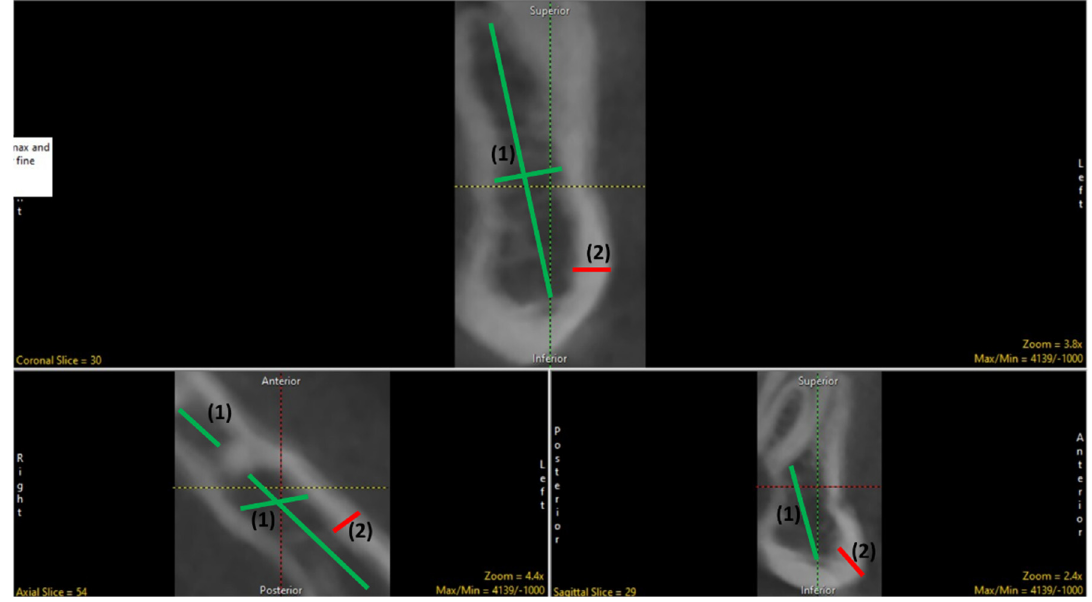
Figure 2. The sub-regioning of data. (1) trabecular bone; (2) cortical bone.